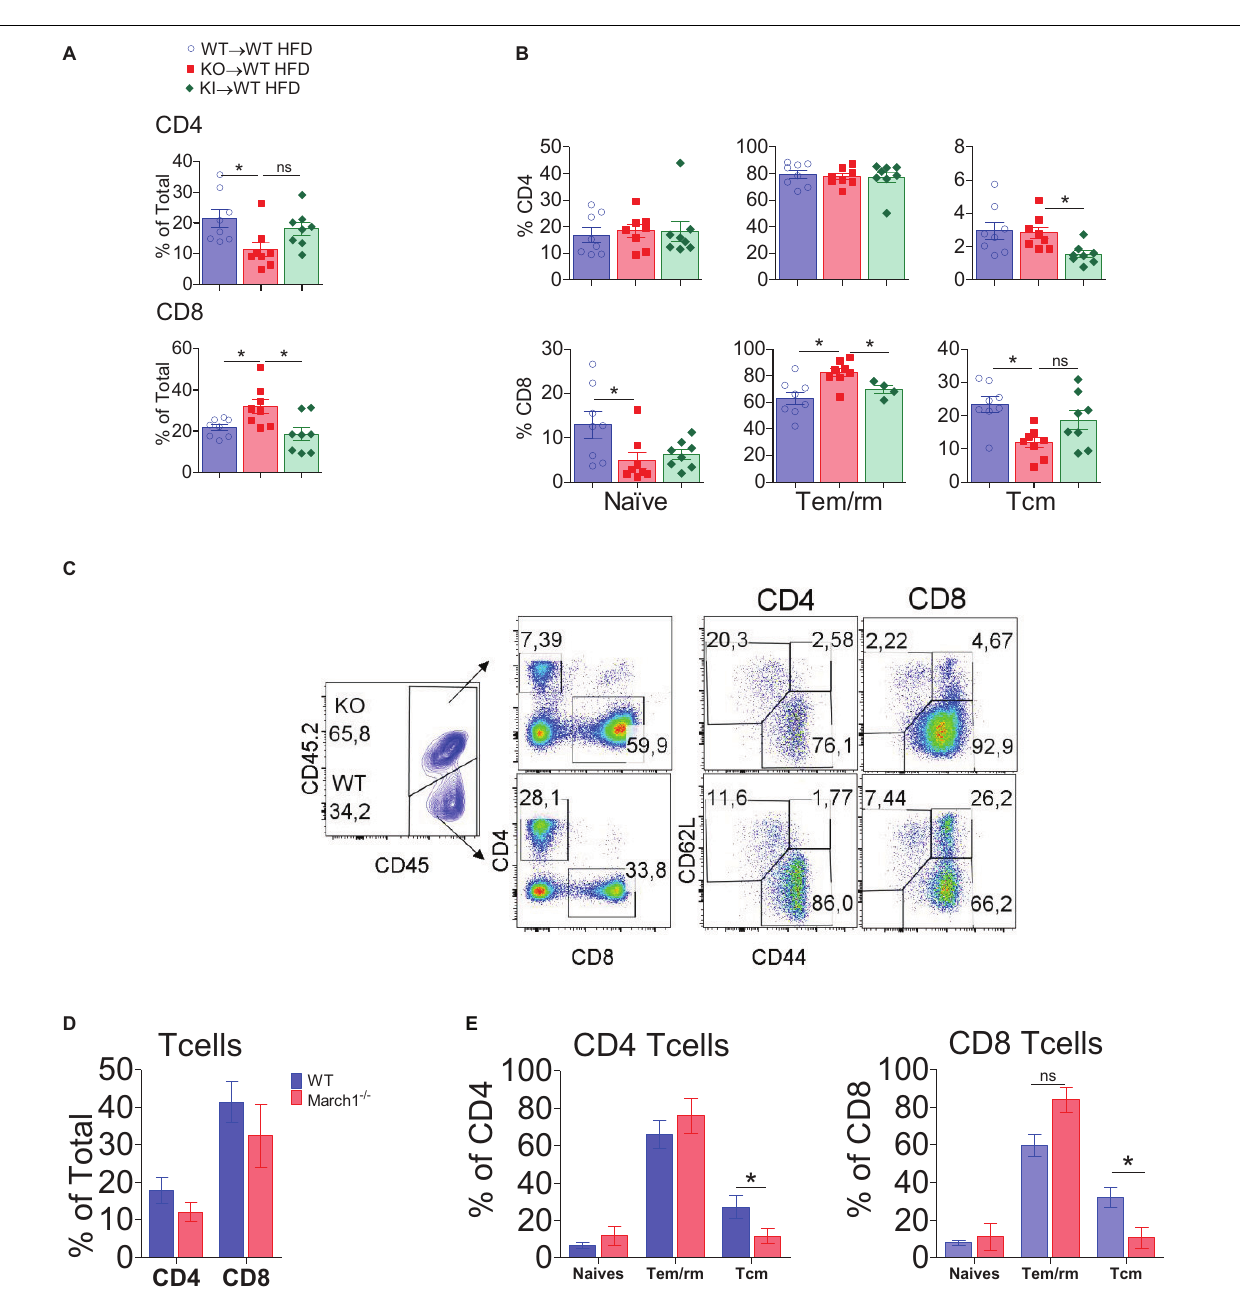
FIGURE 5 | March1 intrinsically affects CD8 T cell infiltration and phenotype in WAT. SVF cells from obese and lean WT → WT, KO → WT and KI → WT BMCs were analyzed by flow cytometry for CD4 + and CD8 + T cells. Proportions of total (A) , naive, effector and memory CD4 + and CD8 + T cells (B) . (C–E) Six week old WT mice ( n = 4) were lethally irradiated and received an i.v injection of a mixture of bone marrow cells from WT (CD45.1) and March1 − / − or MHCII KI (CD45.2) mice. After 8 weeks of reconstitution, these mixed BMCs were fed CD or HFD for 20 weeks. Representative dot plots (C) and the proportions of total (D) , naive, effector and memory CD4 + and CD8 + T cells from WAT (E) . ∗ P <